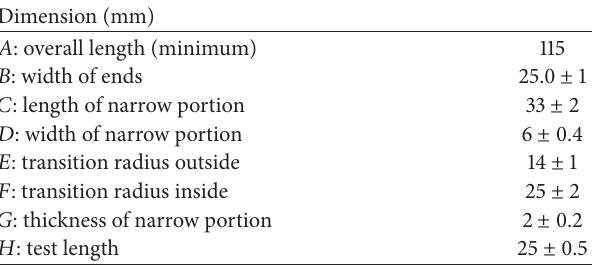
Table 2: Dimensions for dumbbell test specimens according to type 1 of the ISO 37:2005 specifications and/or type C of ASTM.D412 specifications. Each uppercase letter relates to the corresponding dimension as indicated in Figure